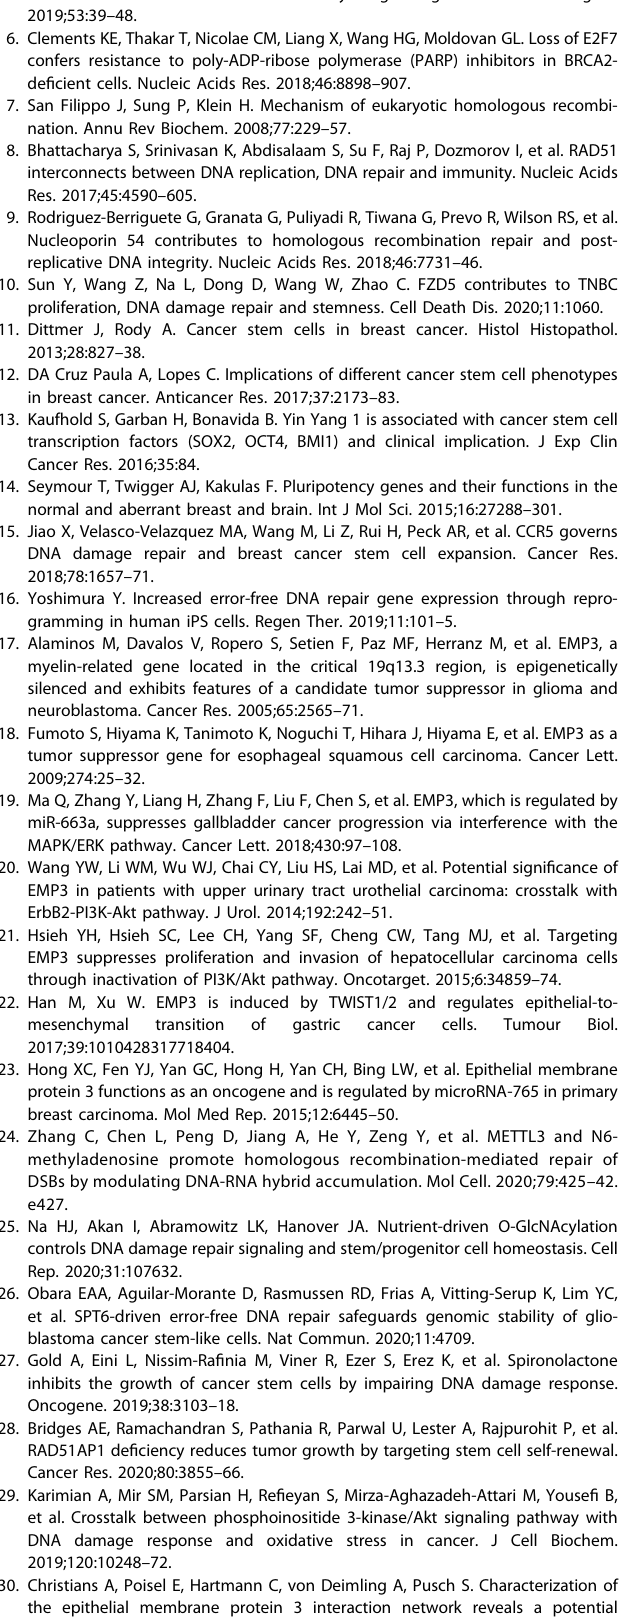
Table 1. Primers for real-time